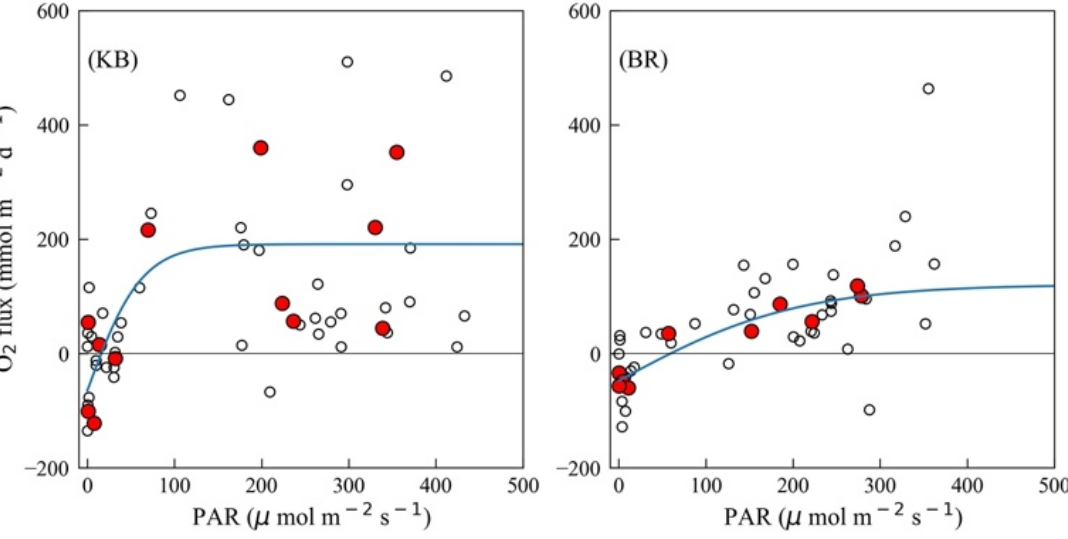
Figure 7. Relationships between PAR and net O 2 flux in KB and BR. The open circles represent net O 2 fluxes during daytime and the red solid circles represent hourly mean fluxes. Table 1. Photosynthesis parameters and net ecosystem metabolism in KB and BR. P max , R d , GPP, R, and NEM are in mmol m –2 d –1 , I k and I c are in μ mol photon m –2 s –1 , and α is in mmol m –2 d –1 / μ mol photon m –2 s –1 .